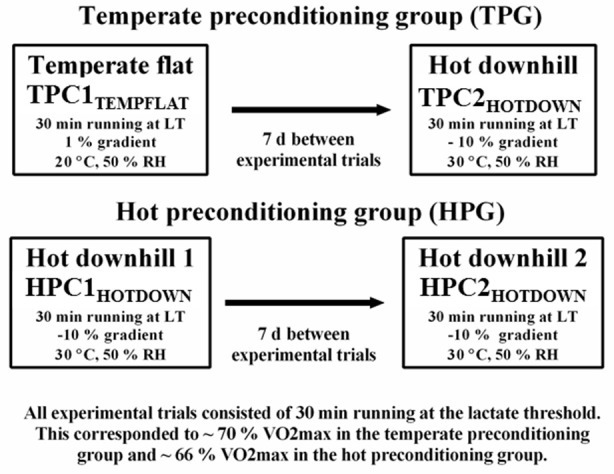
Schematic representation of the experimental design. V˙O2max (maximum oxygen uptake).